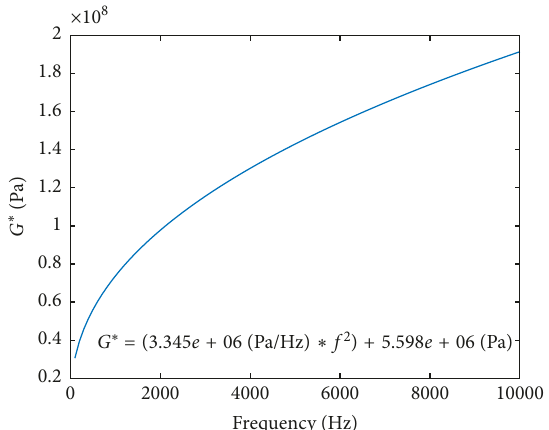
Figure 3: The relation between shear modulus and frequency of a typical viscoelastic material.